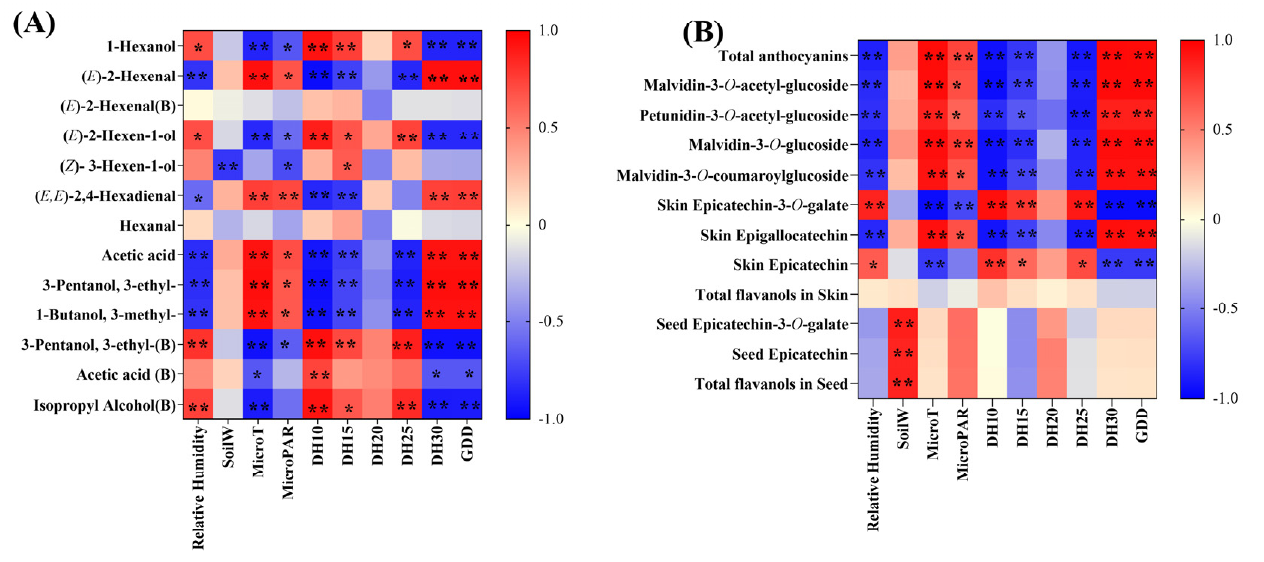
Figure 5. Pearson correlation analysis revealing the relationships between the climate indicators and the marker aroma compounds ( A ), and the marker flavonoids compounds ( B ). Different cell colours in the heatmaps represent a positive (red) or negative (blue) correlation. ** represents significant correlations at p < 0.01 and * represents significant correlations at p < 0.05. Table 1. Must and wine physicochemical parameters of the clean tillage (CK) and covering peanuts